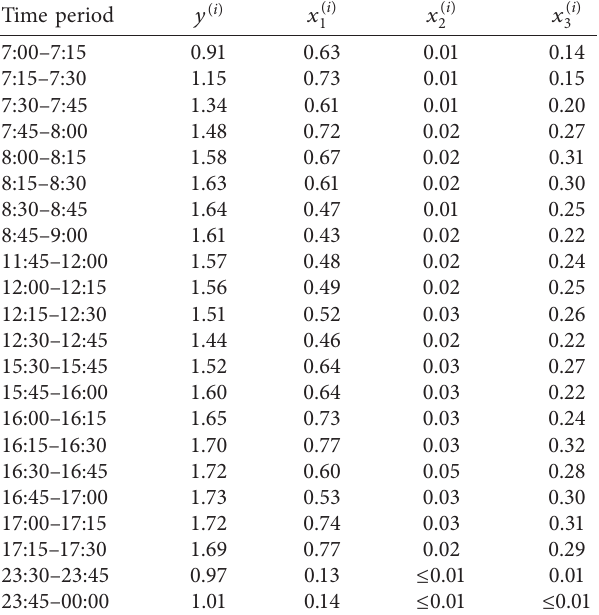
Table 5: Calculated values of the dependent and independent variables in the converted equation (6) based on data of Tieji Road. Time period